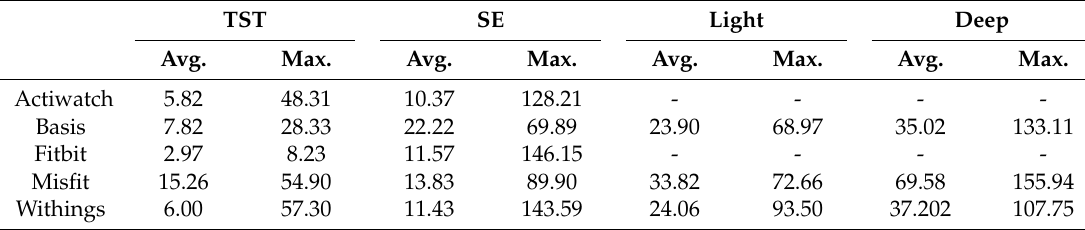
Table 6. Percentage error (average and maximum) for each device. Each value is calculated as 100 * [Absolute value of (Parameter device ´ Parameter PSG )/Parameter PSG .]. Numbers represent unadjusted values. TST SE Light Deep Avg. Max.